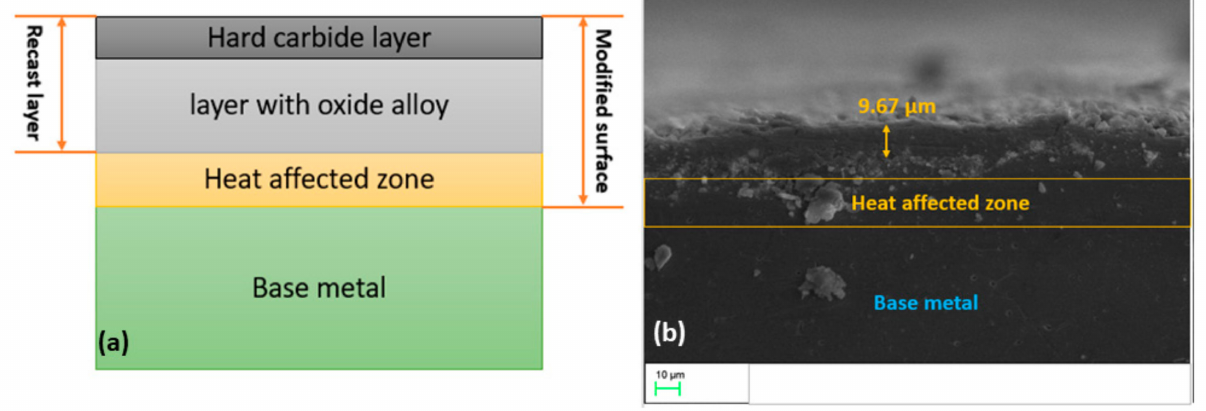
Figure 4. Structure of the modified surface layer: ( a ) illustration of layer, ( b ) obtained layer using the PM-EDM technique (reproduced with permission from ref.